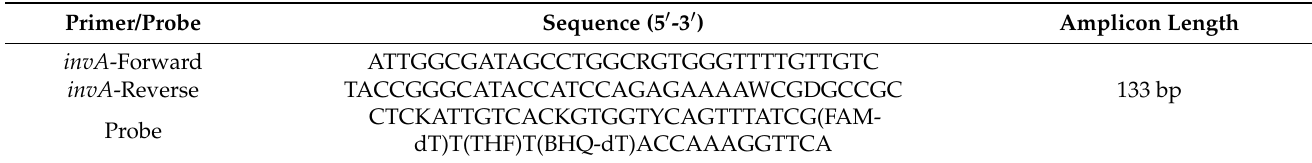
Table 1. The information of primer and probe in this